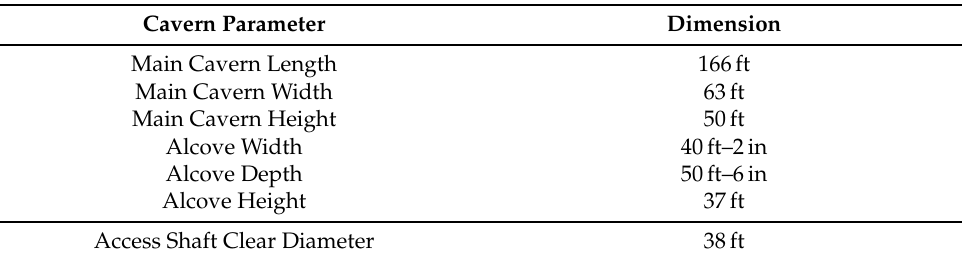
Table 23. Approximate underground cavern size parameters. Actual dimensions will be determined during the final design phase.